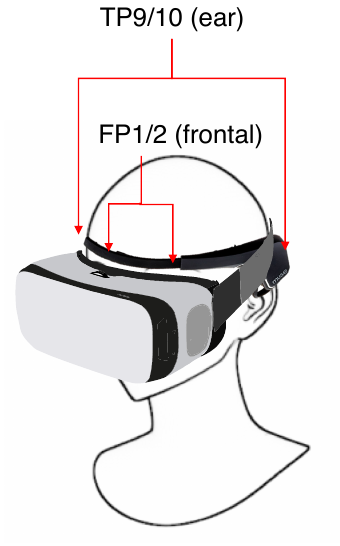
Figure 2. Schematic view of the placement for the EEG headband (top) and the VR viewer (bottom). The headband’s electrodes connect at four positions on the forehead (TP9, Fp1, Fp2 and TP10 positions) of the subject and behind the ear for a